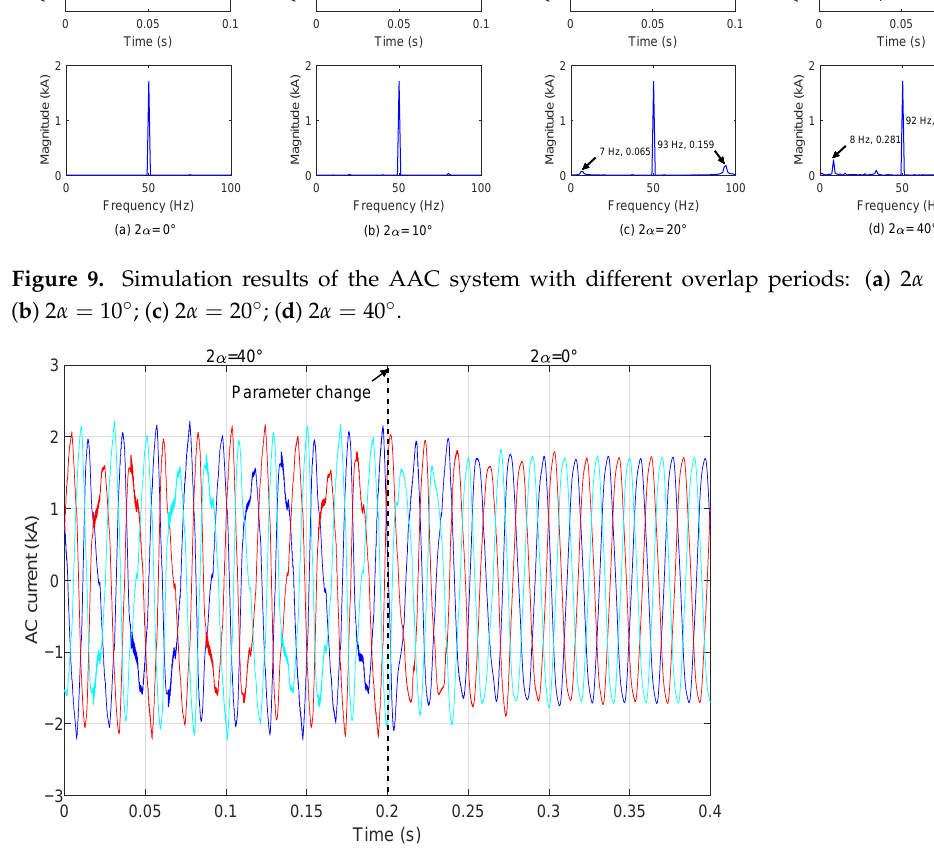
Figure 10. Waveform of AC current under parameter